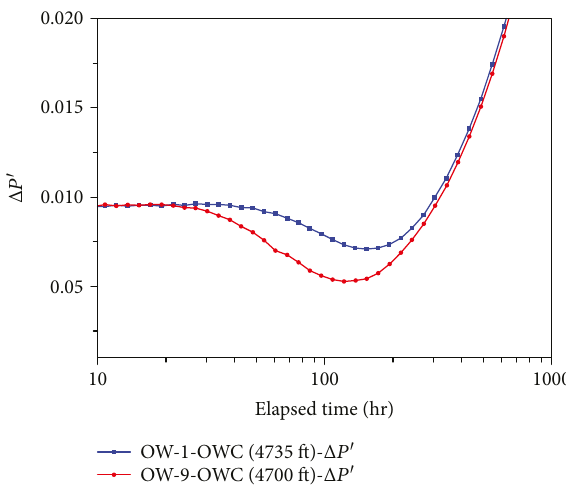
Figure 10: The log-log plot of drawdown for closed system. It shows that the pressure derivatives for di ff erent OWC cases all together go down in transition zone, but for high OWC case, the pressure derivative goes down in advance and much deeper.